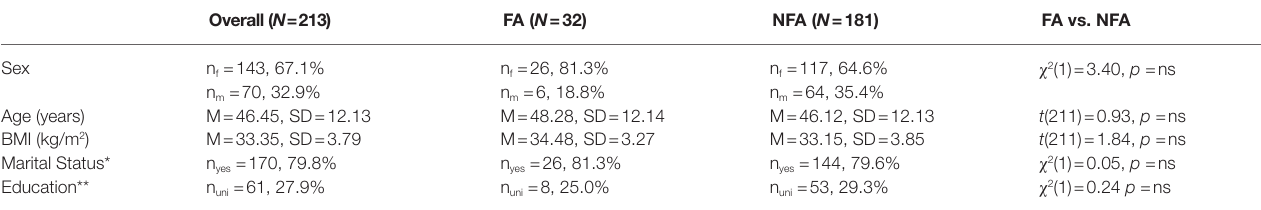
TABLE 2 | Sociodemographic factors (FA vs.